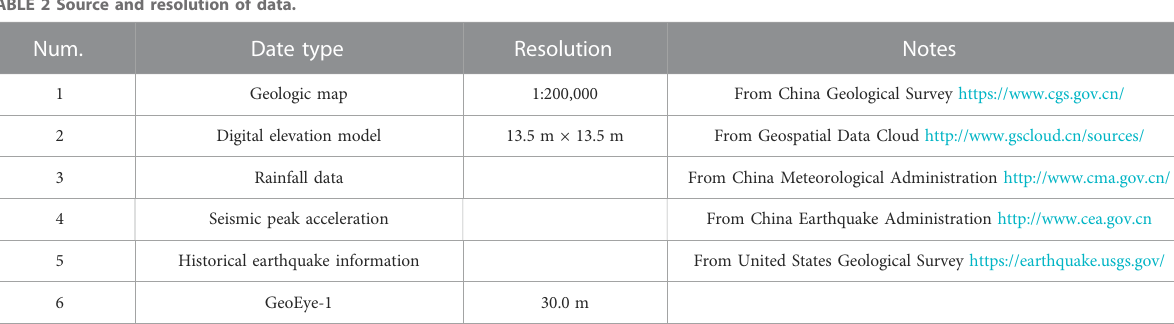
TABLE 2 Source and resolution of data.